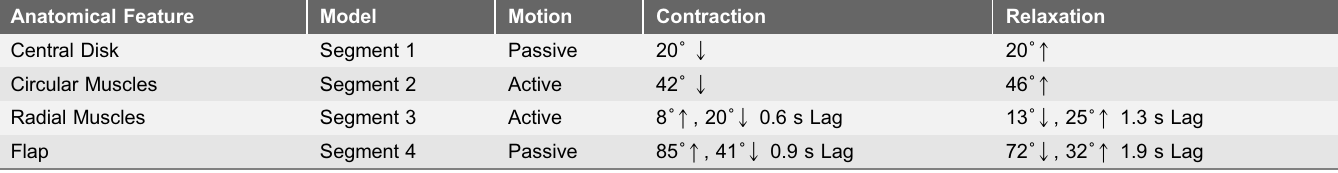
Table 2. Function of anatomical features with corresponding discrete model